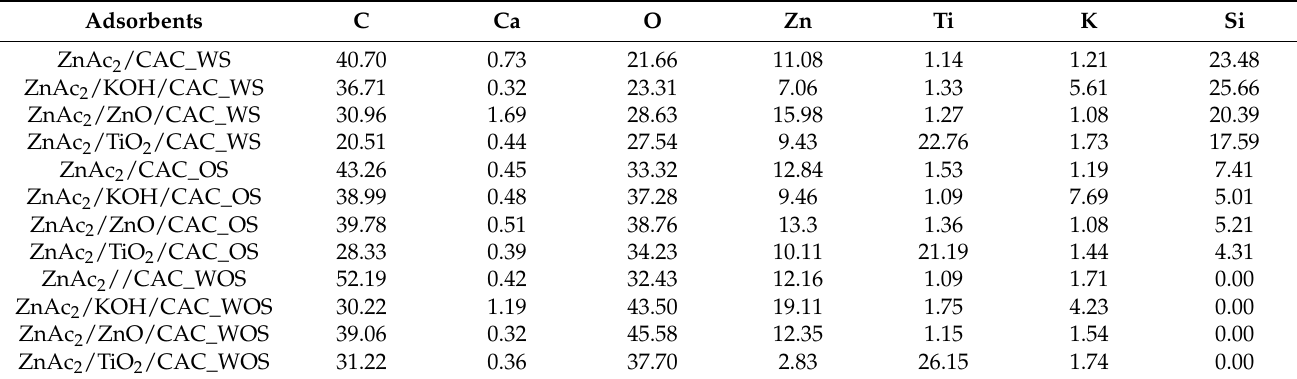
Table 4. Element content on adsorbent